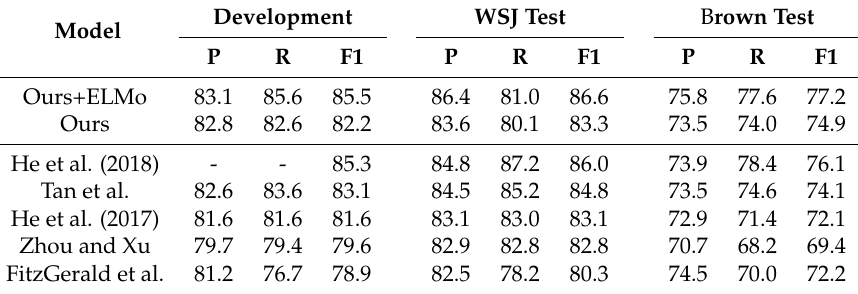
Table 1. Experimental results on the CoNLL-2005.